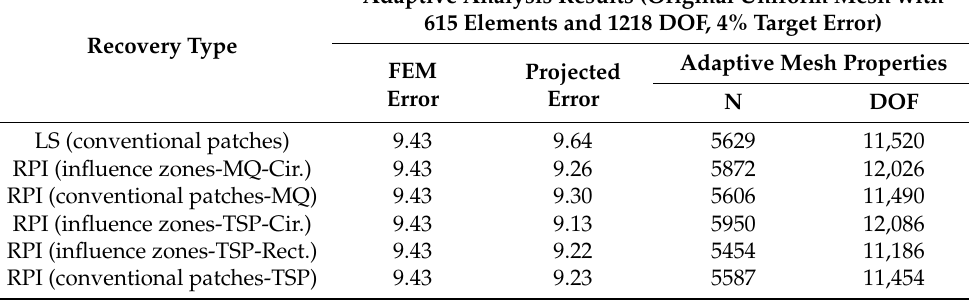
Table 7. Adaptive finite element analysis results (overall errors, total number of elements (N) and DOF) for incompressible-elastic plate with 4% target error using quadrilateral elements. Adaptive Analysis Results (Original Uniform Mesh with 615 Elements and 1218 DOF, 4% Target Recovery Type